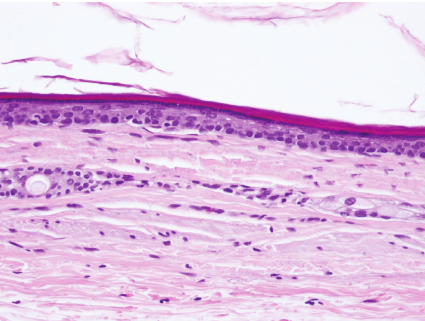
Figure 4: Histopathological examination of the surgical specimen (Haematoxylin and Eosin).